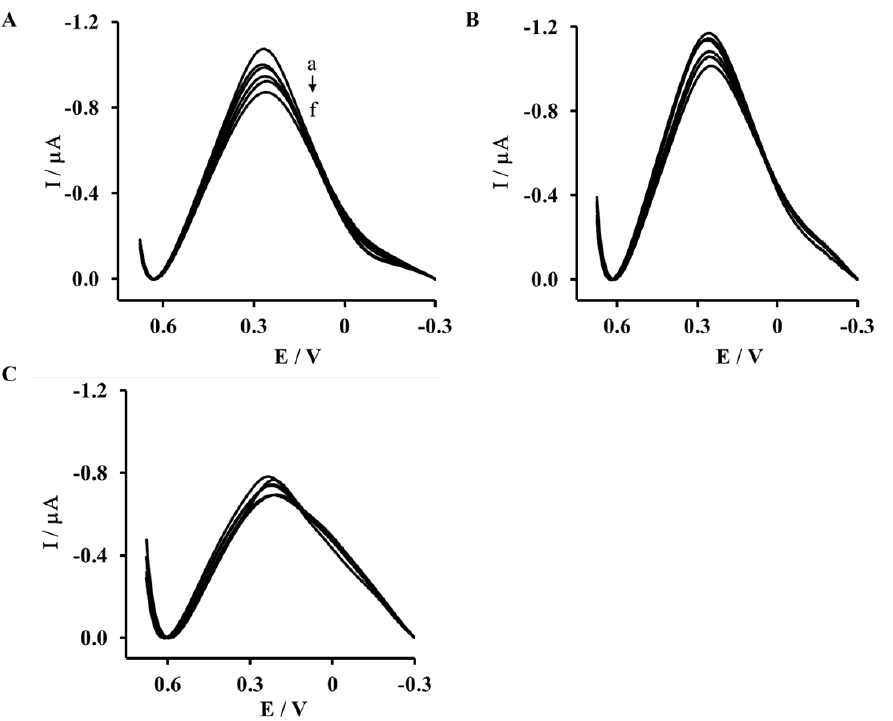
Figure 4. The representative Osteryoung Square Wave Voltammetry (OSWV) responses measured with electrodes: ( A ) Au-NAC/DPTA–Cu(II)–His TRIS buffer in the presence of Ca 2+ ; ( B ) Au-NAC/DPTA–Cu(II)–His domain in TRIS buffer without Ca 2+ and ( C ) Au-NAC/DPTA–Cu(II)–His domain in TRIS buffer in the presence of Ca 2+ towards S100B protein: ( a ) 0.0; ( b ) 1.0; ( c ) 5.0; ( d ) 10.0; ( e ) 15.0; and ( f ) 20.0 [pM]. Buffer composition: 50 mM TRIS-HCl, pH